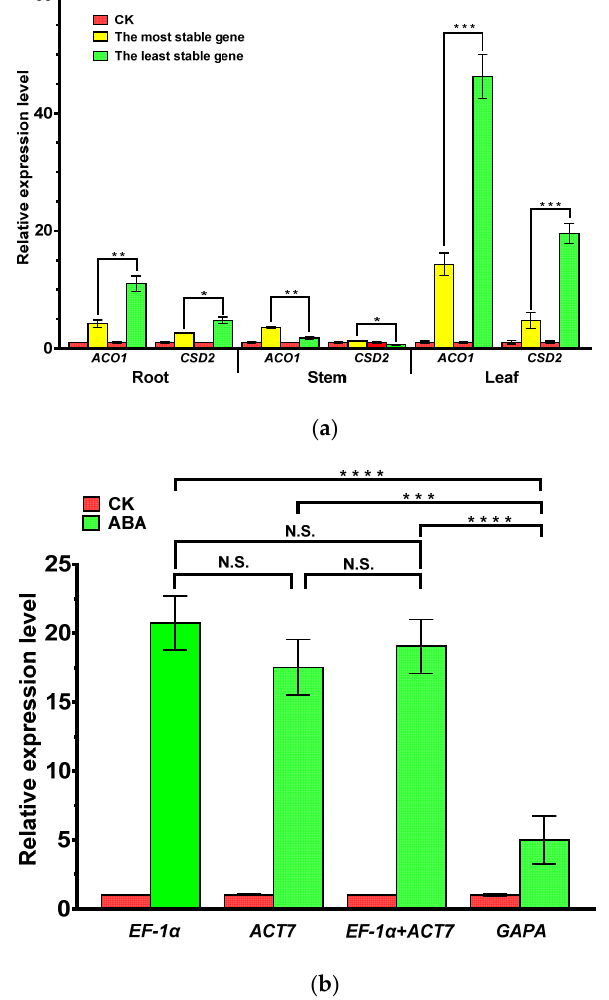
Figure 5. Validation of the selected reference genes. Relative expression levels of ACO1 and CSD2 were normalized using candidate reference genes under different treatments. ( a ) The expression level was normalized using the most stable and unstable reference genes in various organs under cold treatment. The most stable and unstable reference genes in the roots, stems, and leaves were TBP1 and EF-1 α , EF-1 α and ACT7 , and TUB1 and EF-1 α , respectively. ( b ) The expression level of ACO1 was normalized using the most stable reference genes and their combination in roots under ABA treatment. EF-1 α and ACT7 represent the two most stable reference genes, and GAPA is the most unstable gene. Data are displayed as means ± SEM ( n = 3), and the statistical analyses were performed using multiple comparisons of one-way ANOVA to compare those between two reference genes or combinations for normalization. * p < 0.05; ** p < 0.01; *** p < 0.001, **** p < 0.0001. N.S.: no significant